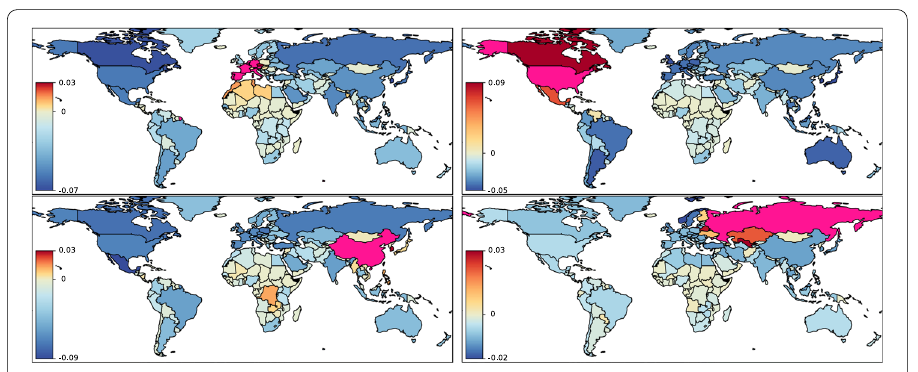
Fig. 7 Labor cost sensitivity. Labor cost sensitivity of country balance dB c / d σ c ′ for KEU9 (top left panel), USA (top right panel), China (bottom left panel), Russia (bottom right panel) for year 2018 (sensitivity is obtained from PageRank-CheiRank probabilities). The diagonal term dB c / d σ c is shown by a fixed magenta color with numerical values being dB c / d σ c = 0.30,,0.31,0.30,0.29 respectively for KEU9, USA, China, Russia (this